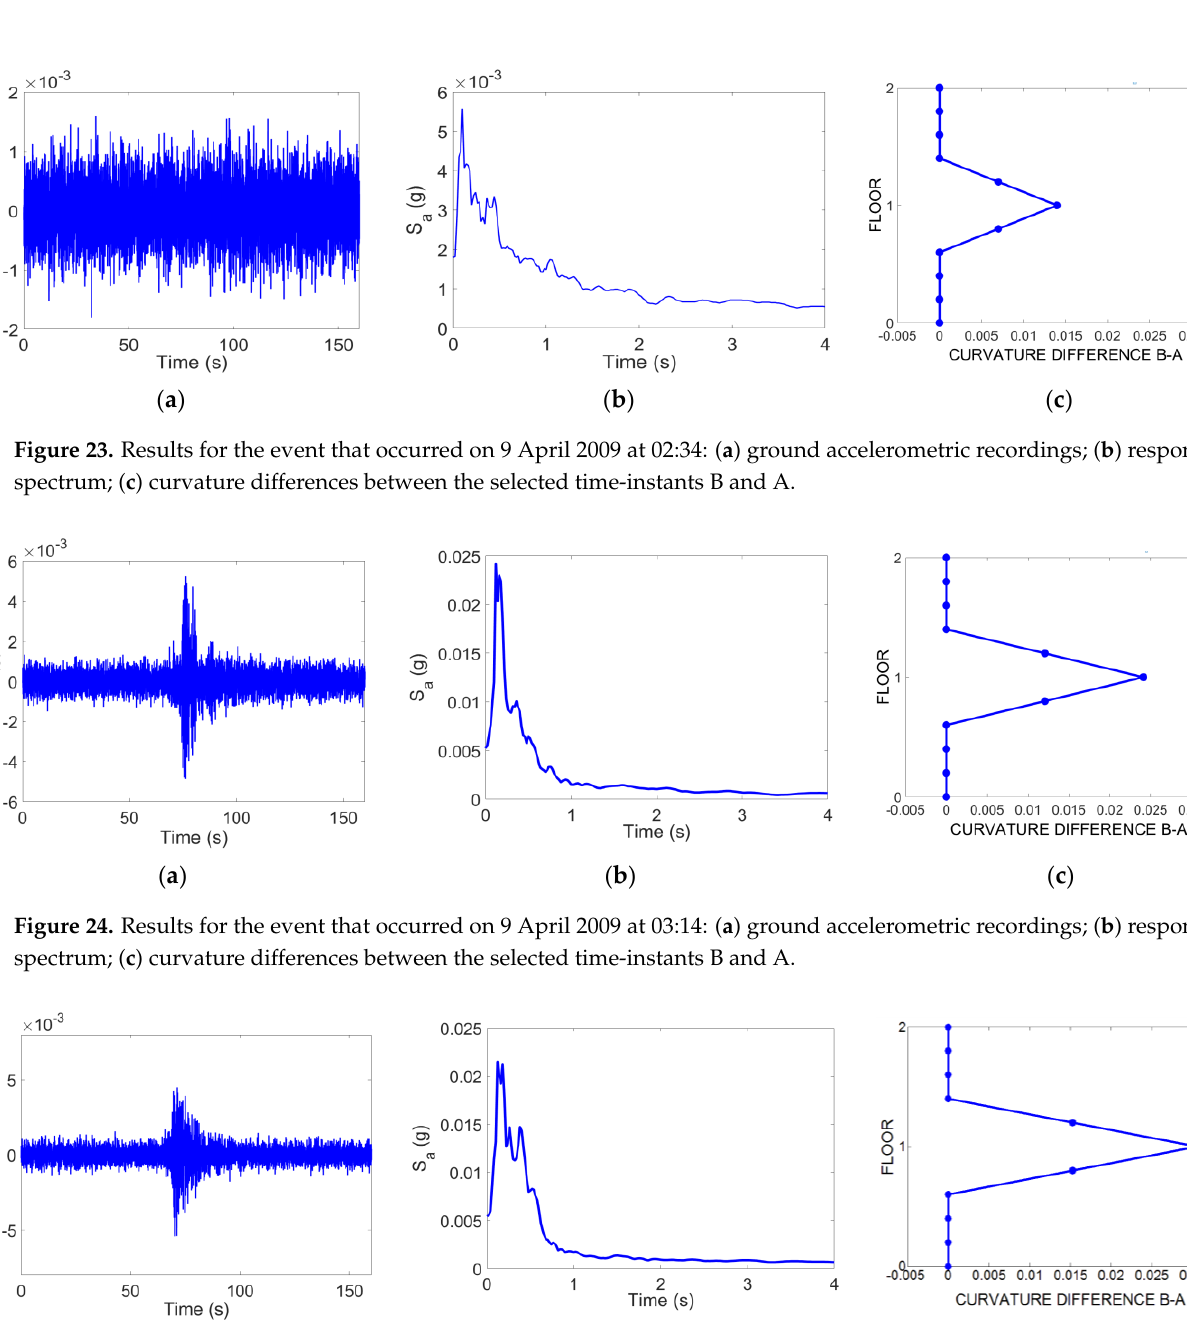
Figure 22. Accelerometric recordings at the different floors of the Navelli municipality building along the transversal direction.